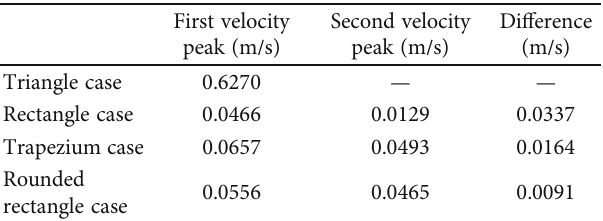
Figure 10: Simulation result of the fourth situation. Table 1: Comparison of the velocity results for four